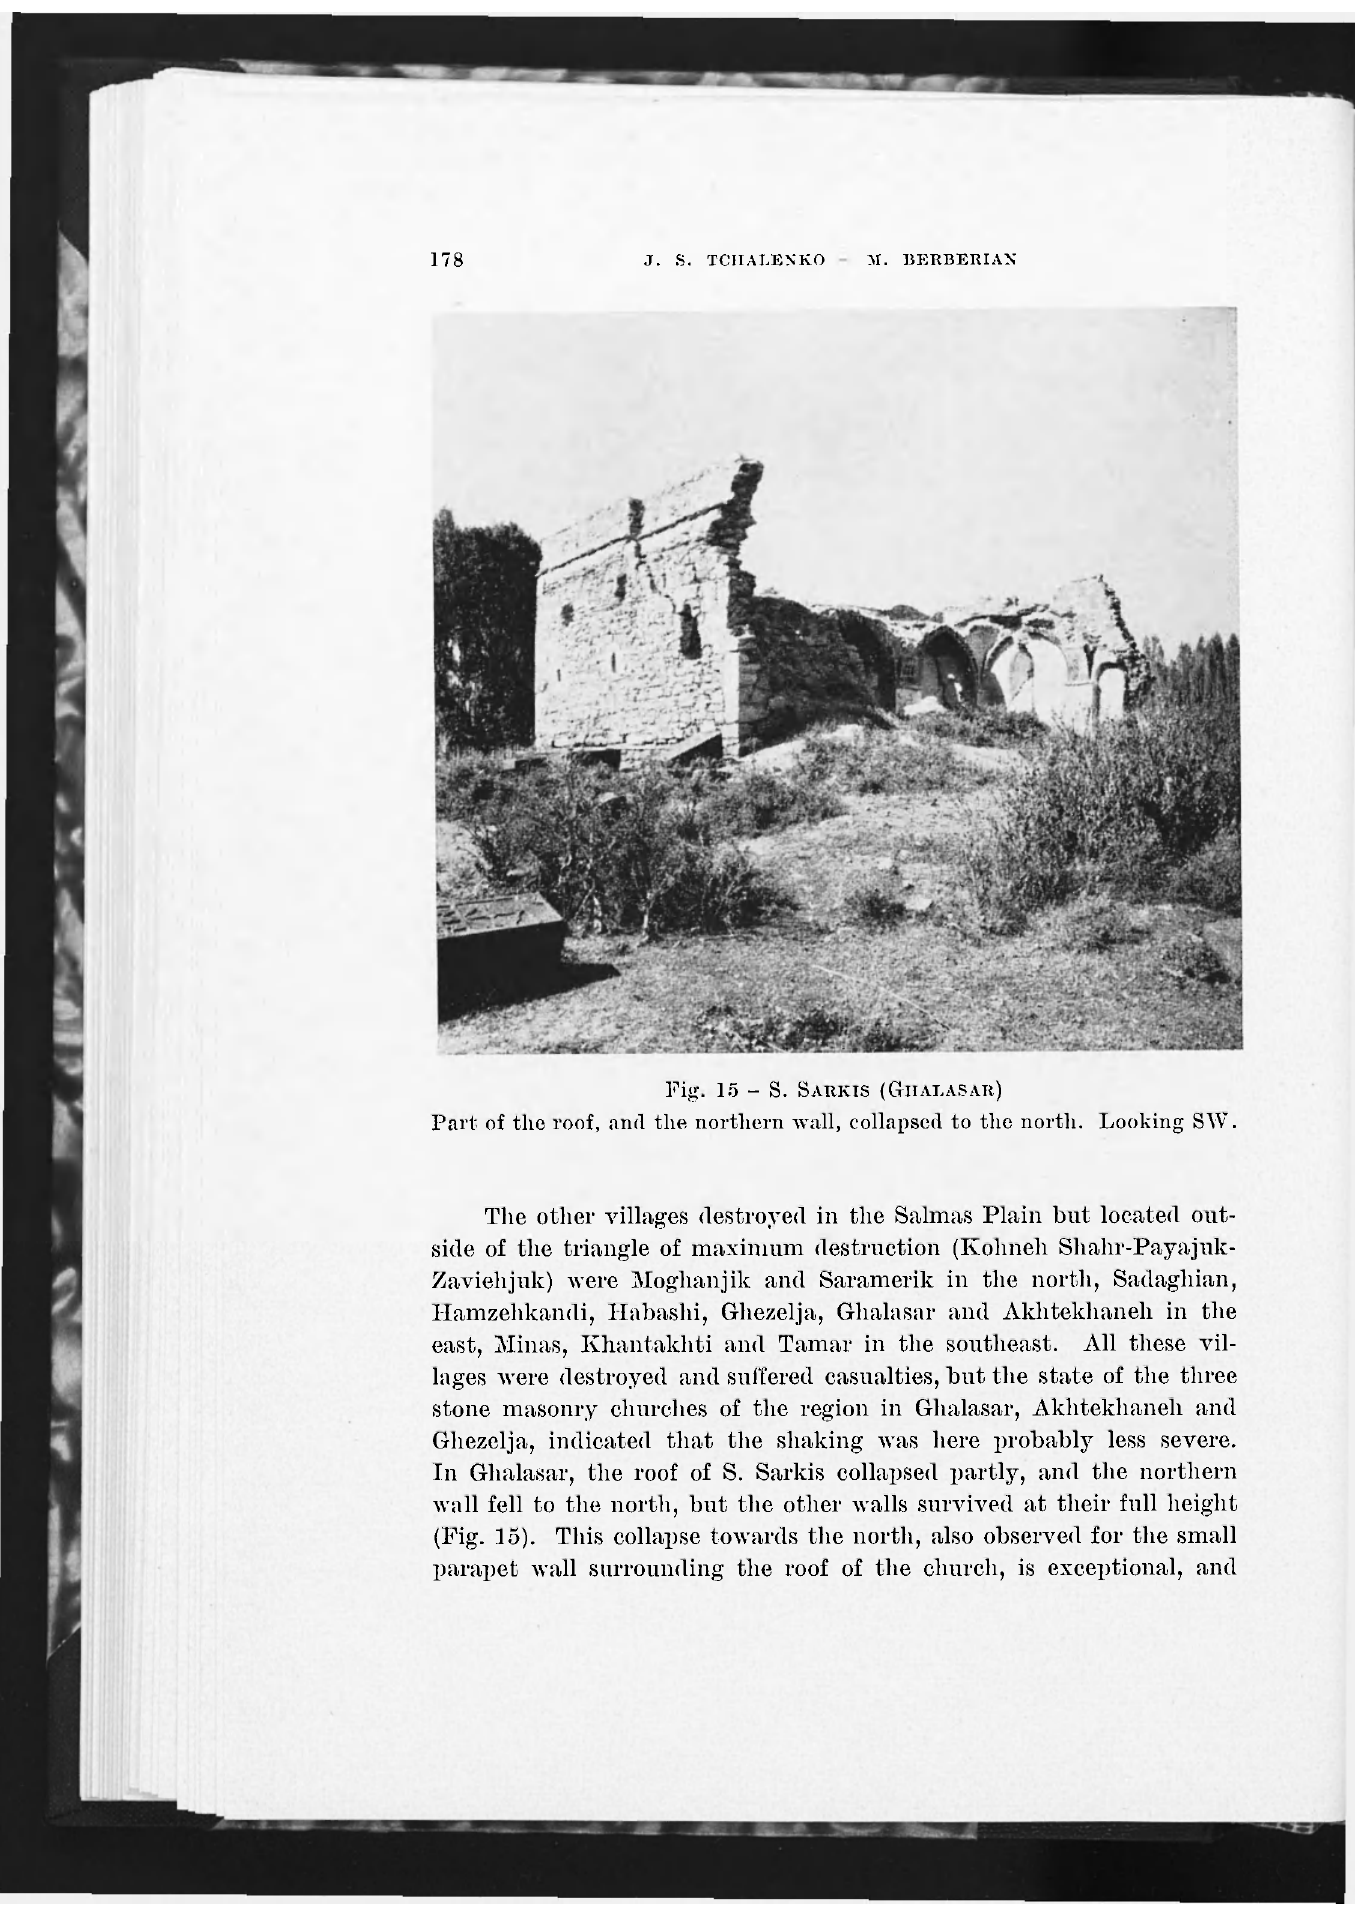
Fig. 15 - S. SARKIS (GHALASAR) Part of tlio roof, and tlie northern wall, collapsed to the north. Looking